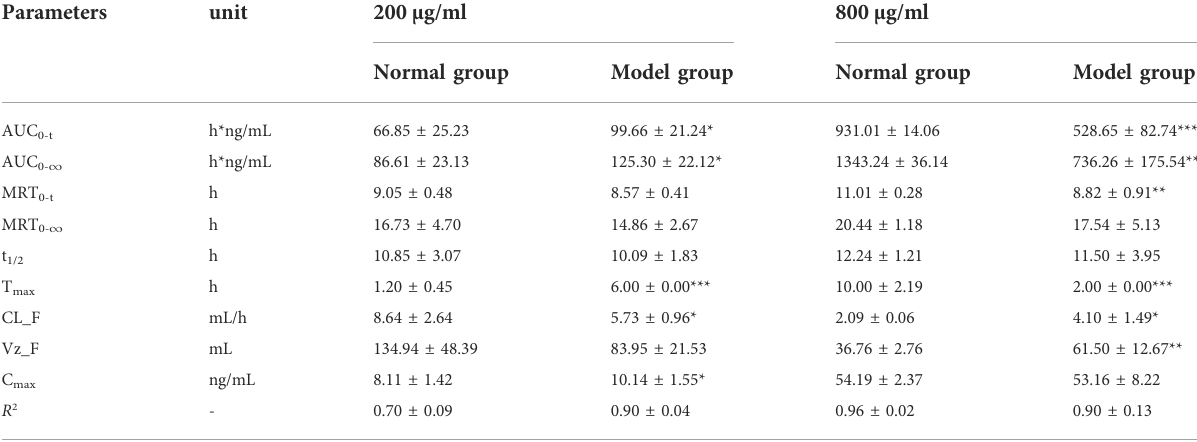
TABLE 2 The pharmacokinetic parameters of luteolin in RAW264.7 cells after treatment with 200 μ g/ml and 800 μ g/ml of I. cappa extracts ( (cid:1) x ± SD, n = 6). Parameters